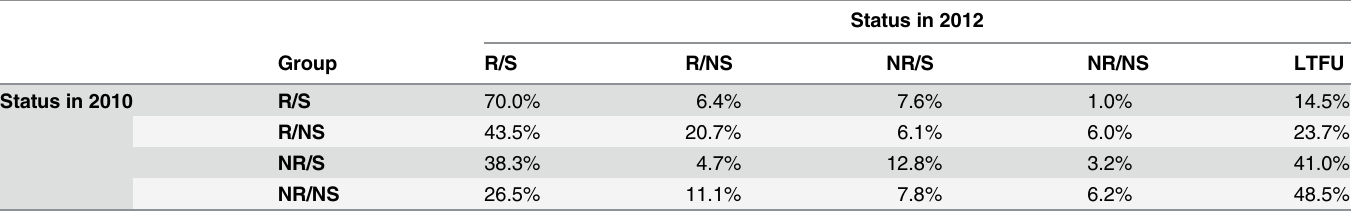
Table 5. Predicted Probabilities for Retention in Care and Viral Suppression Status in Calendar-Years 2012 by Retention/Suppression Status in Calendar-Year 2010, from Multinomial Regression